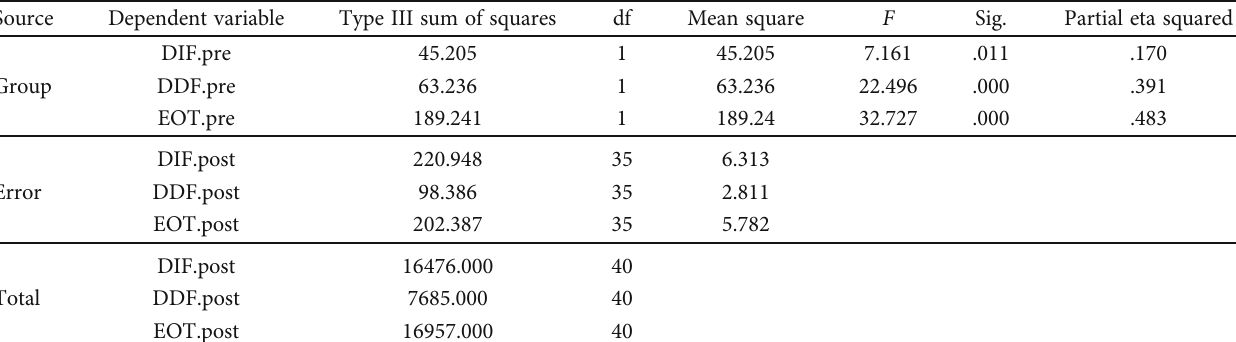
Table 7: Tests of between-subject e ff